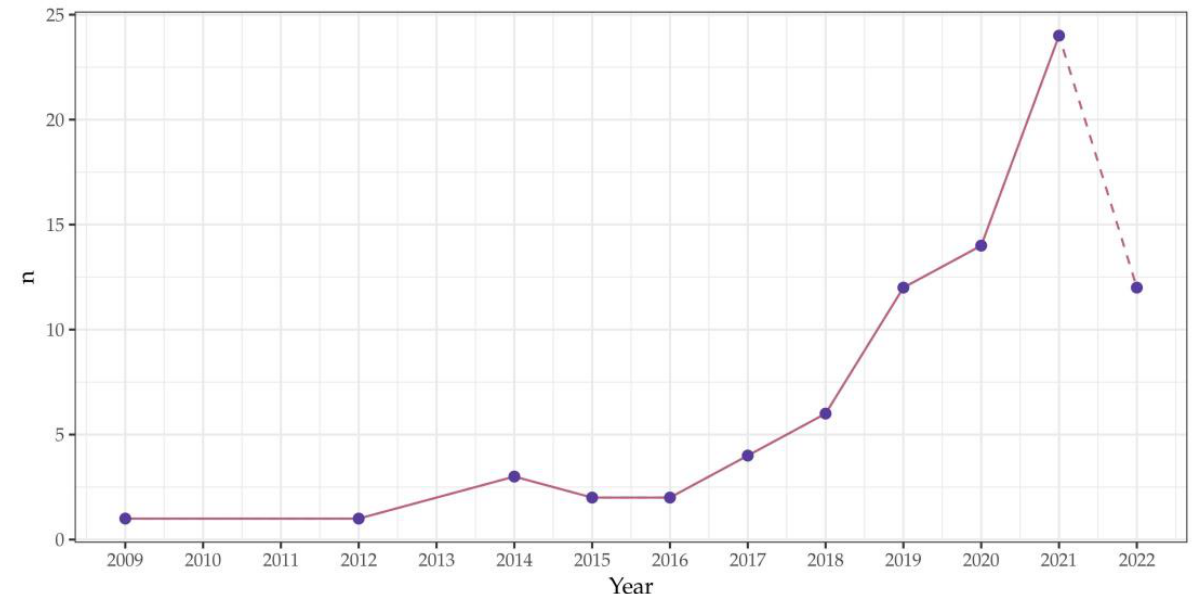
Figure 1. A number of publications including smartphone photogrammetry through the years. Only cited publications were used for this graph.